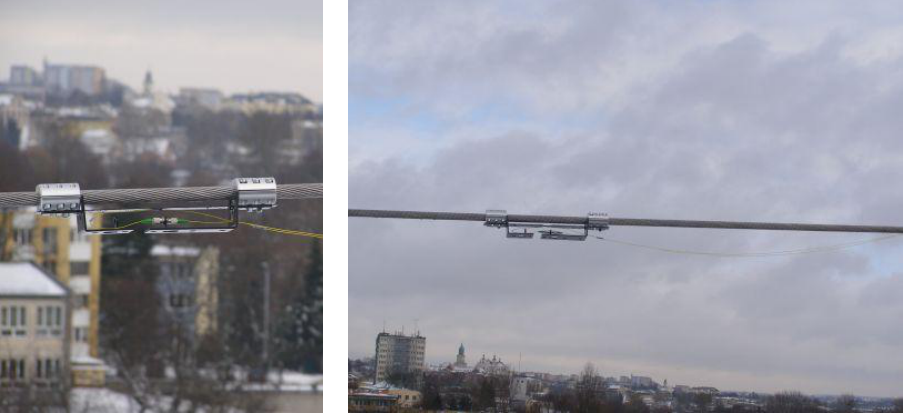
Figure 6. The CFBG based optomechanical system for the power line sag estimation in real conditions.